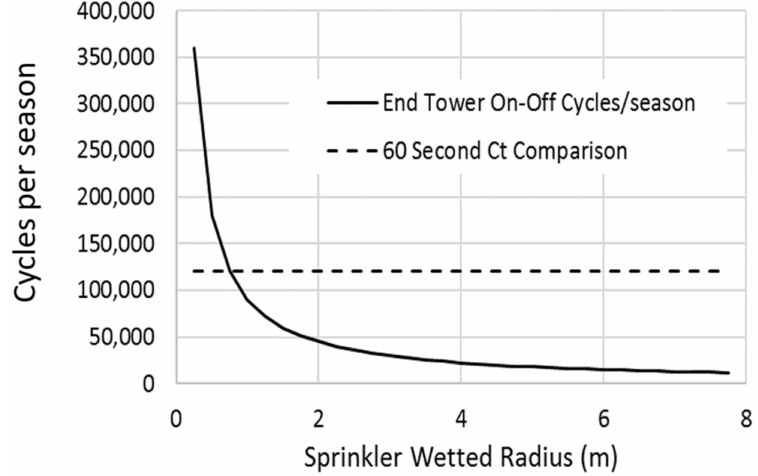
Figure 9. A comparison of the number of pivot tower motor on–off cycles per season when varying the cycle time to move the end tower of the sprinkler’s wetted radius, compared to simply using a 60-s cycle time, assumes 2000 h run time per season and a 2.5 m/min maximum end tower travel speed.